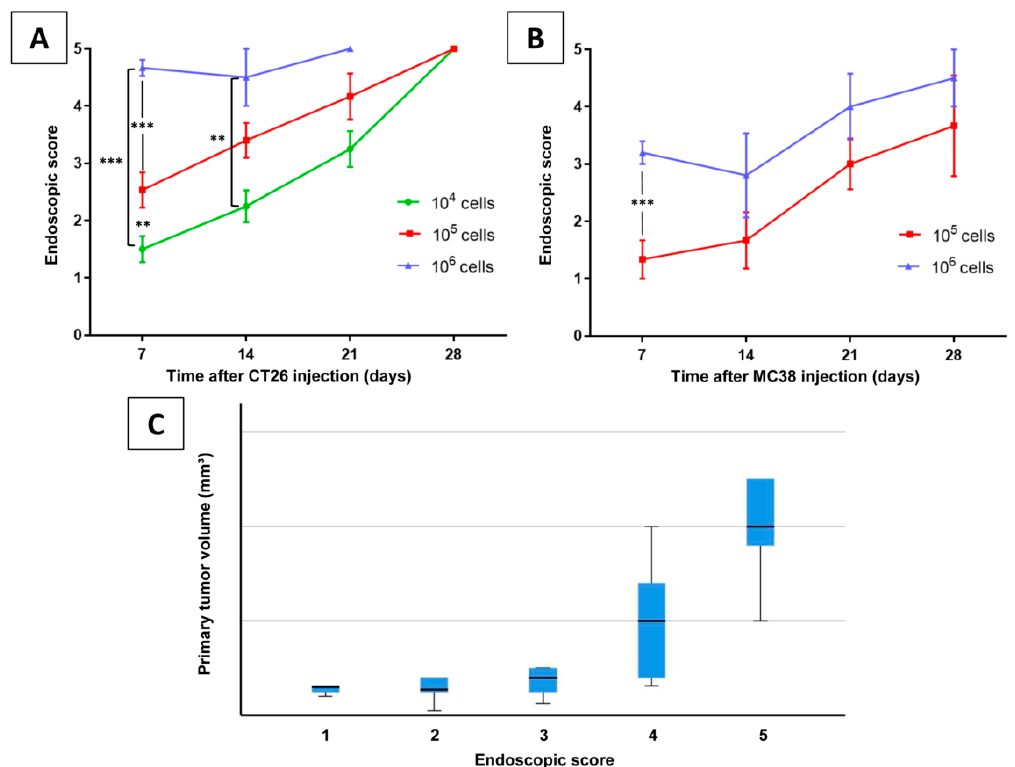
Figure 3. Endoscopic score assigned during follow-up endoscopies on ( A ) BALB/C and ( B ) C57BL/6J mice with varying number of implanted CT26 or MC38 cells, respectively, over an observation period. Significant di ff erences are marked, p values represent Bonferroni-corrected values (** p < 0.01, *** p < 0.001). ( C ) Box plots of primary tumor volume categorized by endoscopic score.